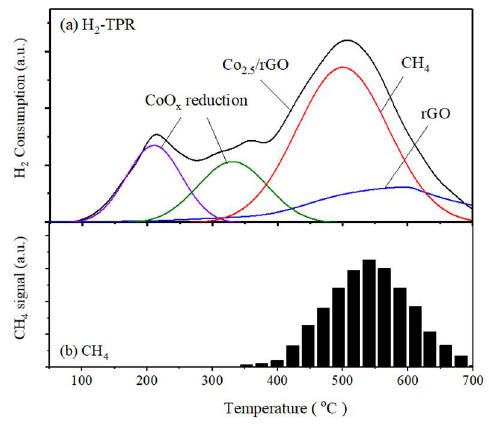
Figure 5. H 2 -TPR patterns of Co 2.5 /rGO ( a ) and CH 4 in the TPR exhaust gas ( b ).